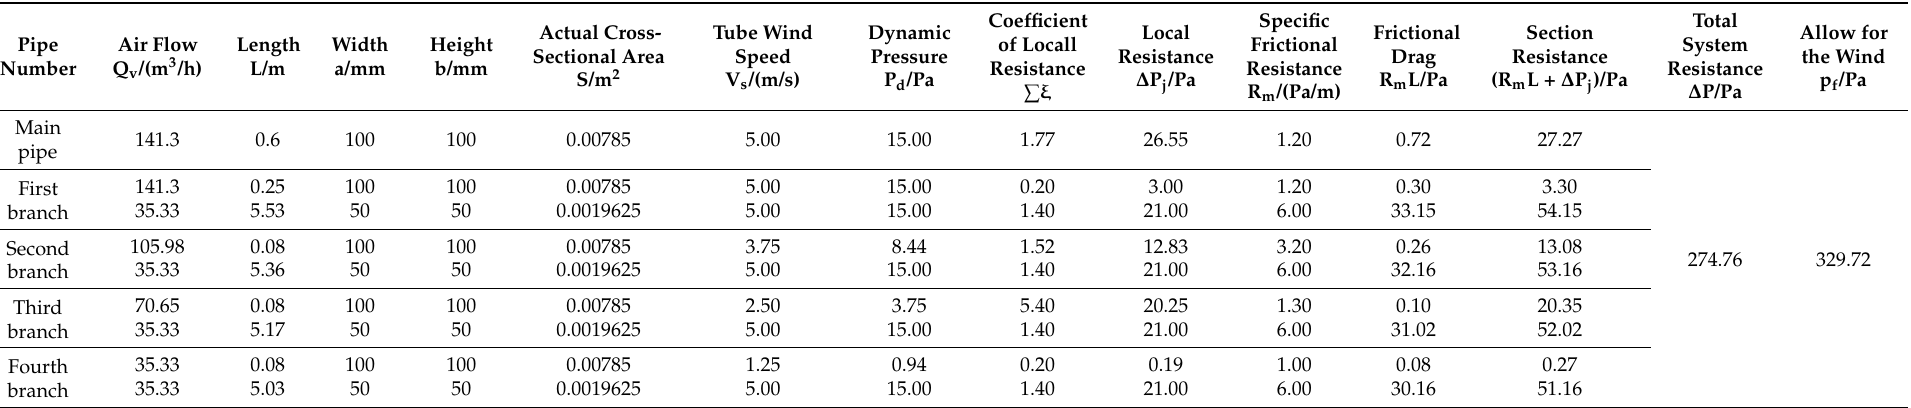
Table 2. Hydraulic calculation of fresh air